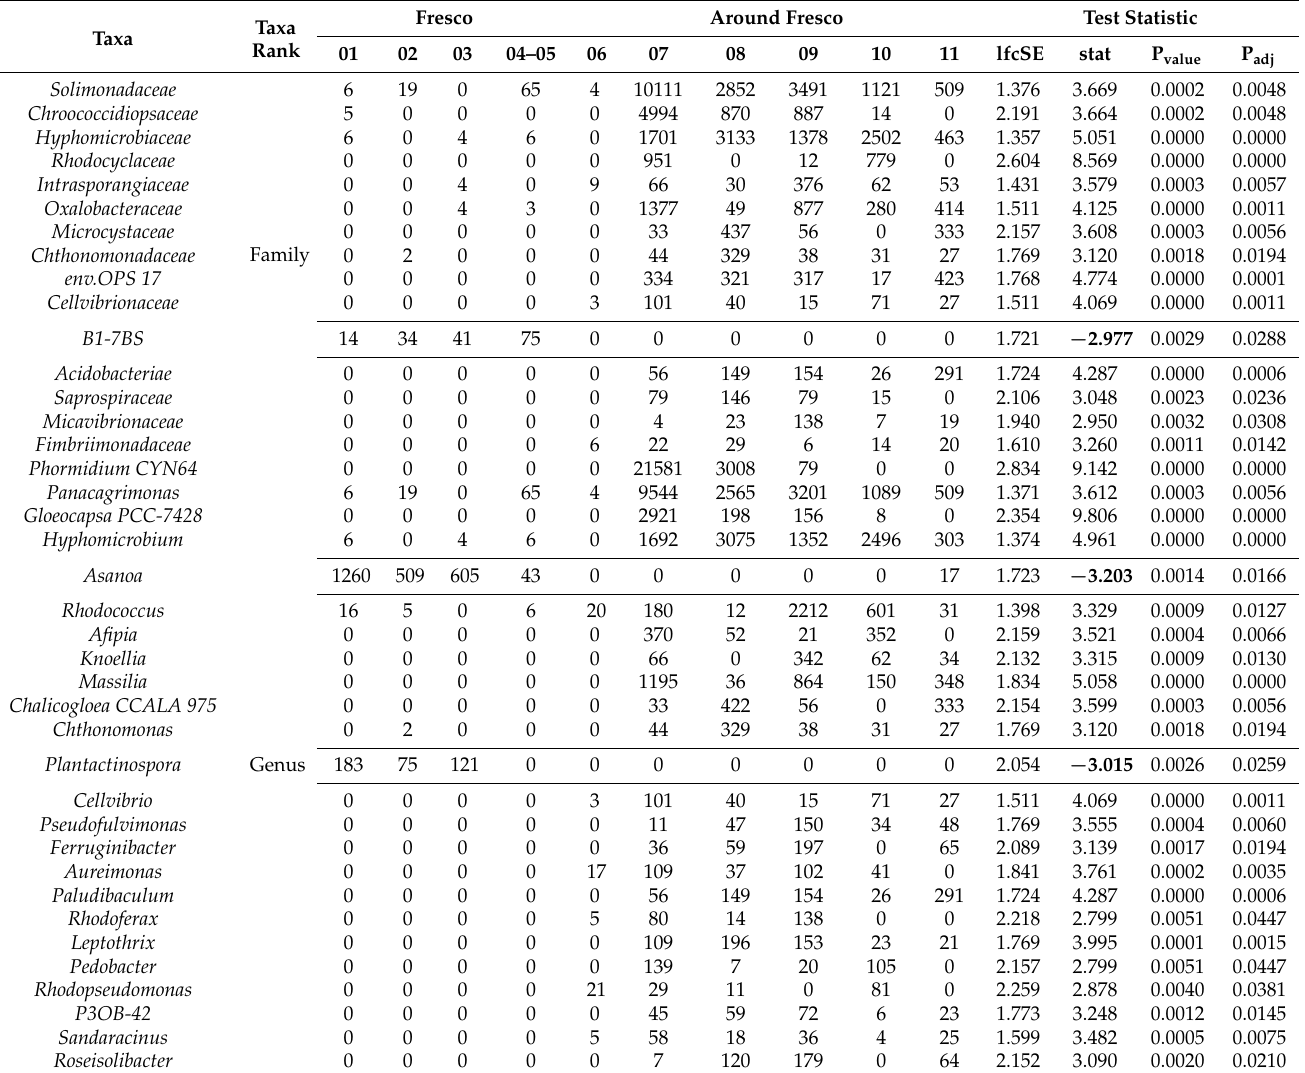
Table 2. Analysis of the differential representation of statistically significant species according to the origin of the